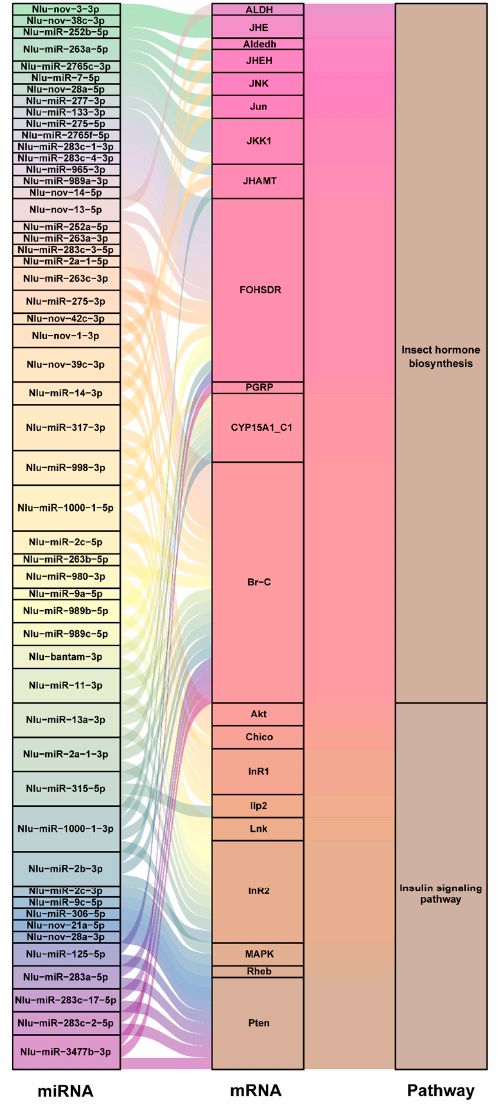
Figure 4. Sankey diagrams of miRNAs, target genes and enriched pathways predicted by